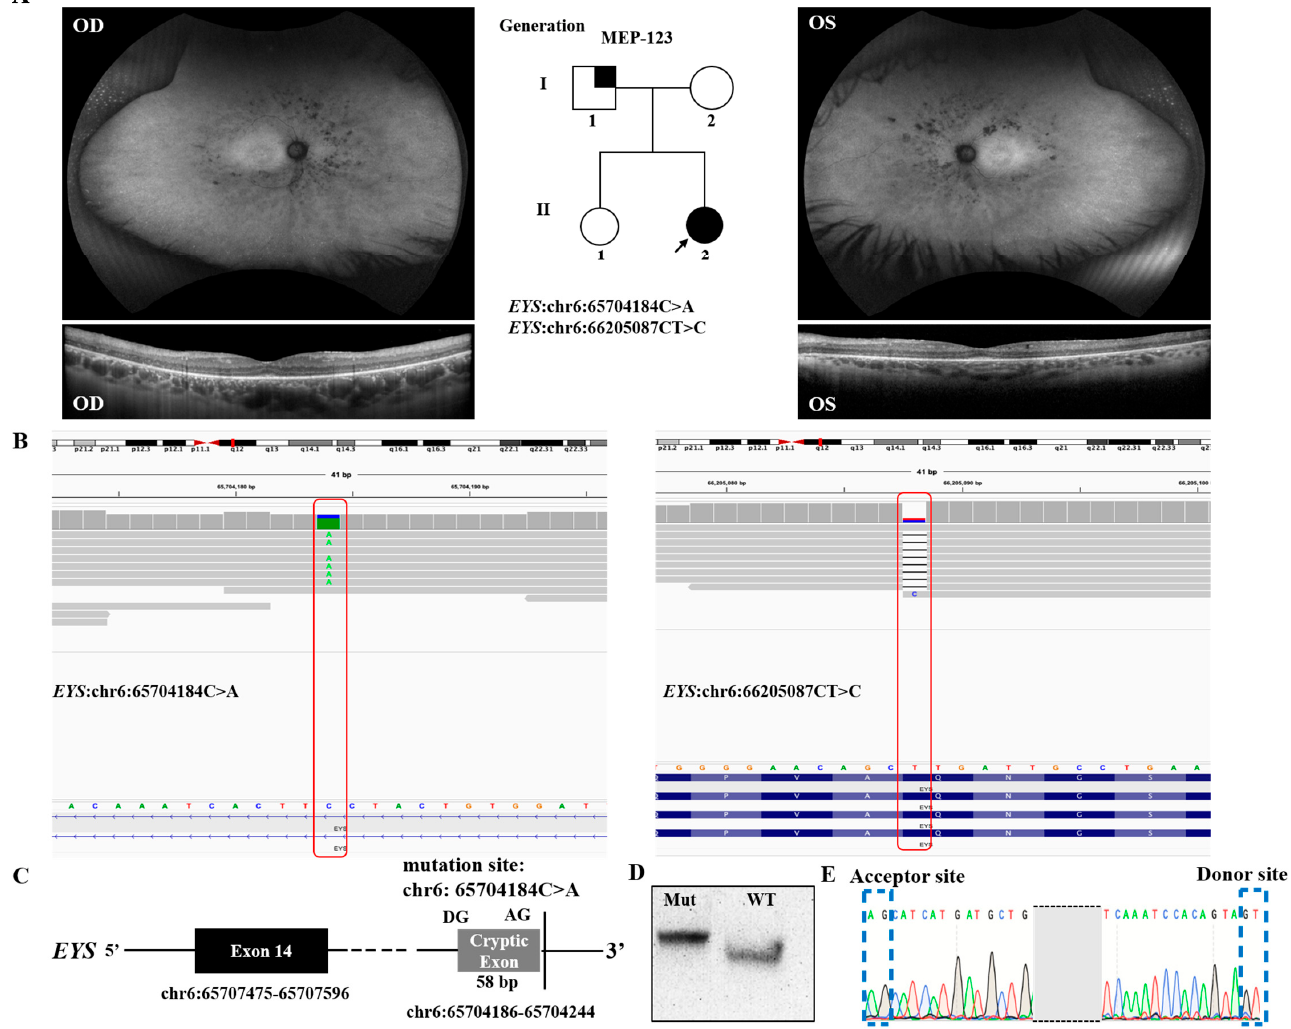
Figure 1. Clinical and functional validation of intronic splicing variant of EYS in MEP-123, who was affected with retinitis pigmentosa (RP). ( A ) Pedigree of proband, fundus autofluorescence (AF), and optical coherence tomography (OCT) for MEP-123. Symbols represent: females (circles), males (squares), affected individuals (filled symbols), unaffected individuals (open symbols), proband (arrowhead), and hearing loss (partially filled symbols). ( B ) IGV plots showing the mutant region. A proband (MEP-123) affected with RP had a pathogenic heterozygous deep intronic variant in EYS (chr6:65704184C>A). The individual also had a pathogenic frameshift variant NM_001142800.2: c.216delA (p.Q72fs). ( C ) Predictive results of novel splicing variant identified in proband. ( D ) Gel electrophoresis of reverse-transcription PCR (RT-PCR) of novel splicing variant and WT. ( E ) Confirmation of novel donor and acceptor sites of cryptic exon via Sanger sequencing. Blue dotted lines are showing donor and acceptor sites.